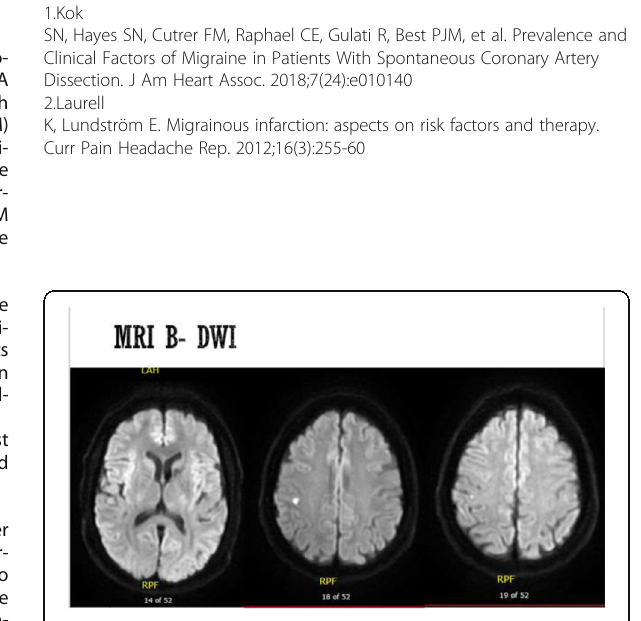
Fig. 1 (abstract P81). See text for